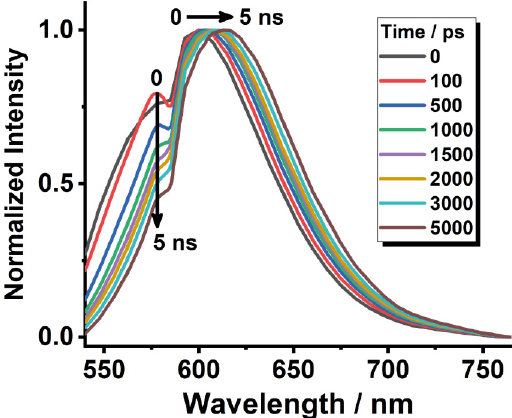
Figure 3. Normalized (to the maximum intensity) TRES of DCM/Al-ITQ-HB using initial dye concentration of 1 × 10 − 3 M upon excitation at 470 nm and gating at the indicated delay times.